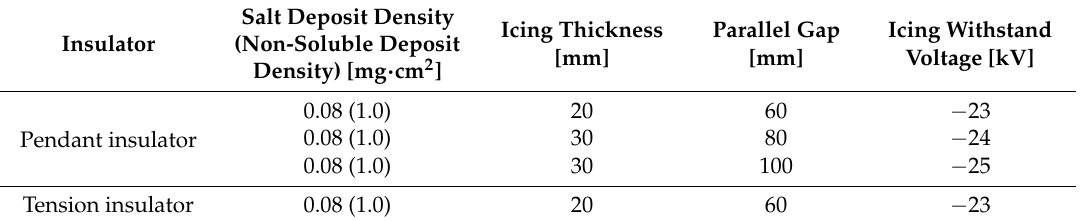
Table 3. Icing test results of the ground wire insulator and parallel discharge clearance.